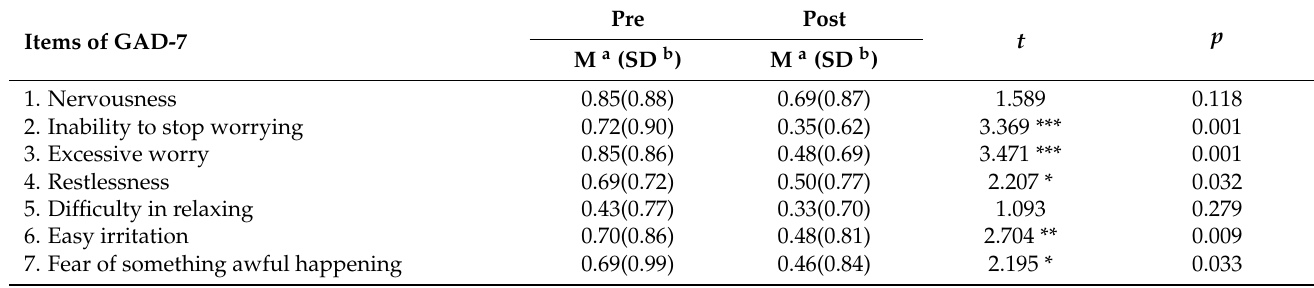
Table 3. Comparison of detailed analysis of GAD-7 within the intervention